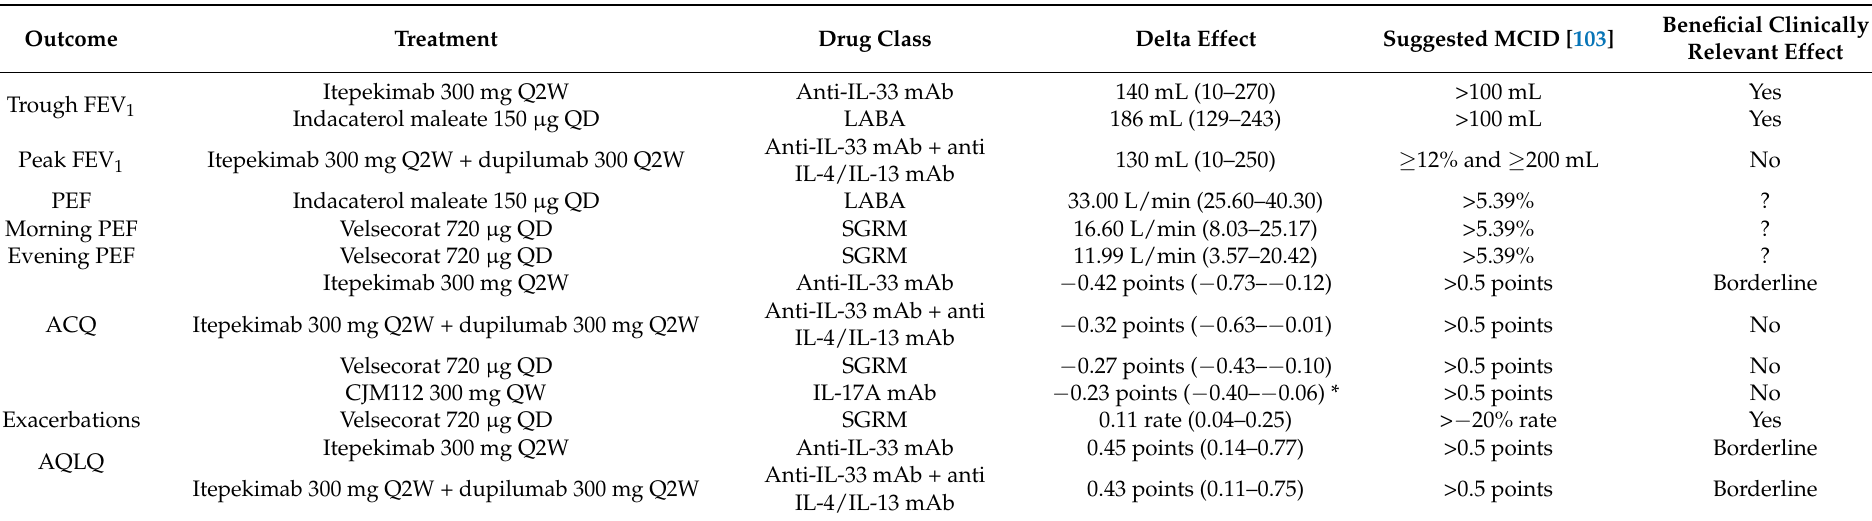
Table 2. Clinical effect of investigational agents currently evaluated in Phase I and II RCTs for the treatment of asthma compared to PCB on efficacy outcomes for which the MCID values are currently available. The investigational agents reported in this table also elicited statistically significant improvement vs. PCB ( p <